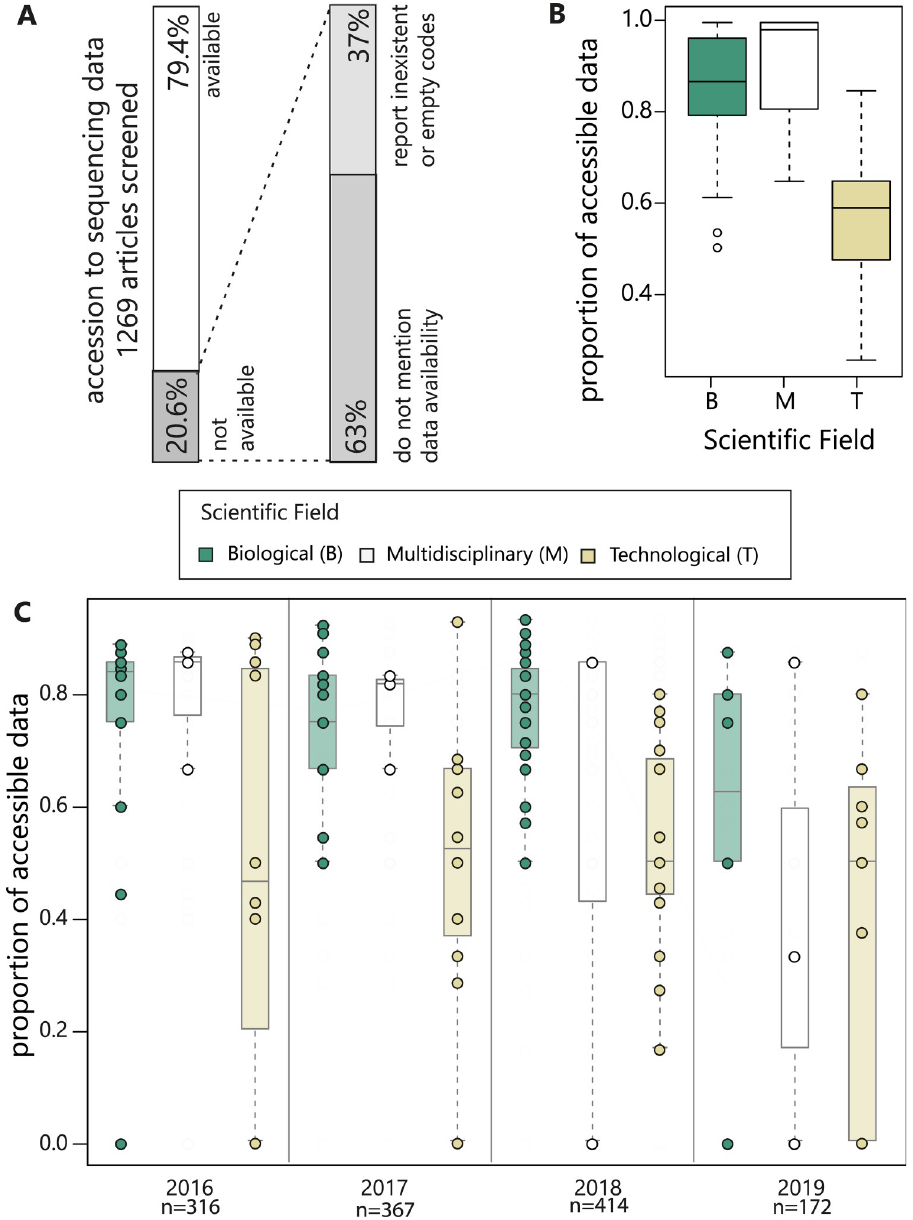
Fig 1. Main trends in accessibility of metagenomic data. (A) Proportion of papers with accessible metagenomic data and type of inaccessible data (grey) (B) in B, M, or T journals. (C) Temporal trends divided by B, M, and T journals. B, biological; M, multidisciplinary; T,